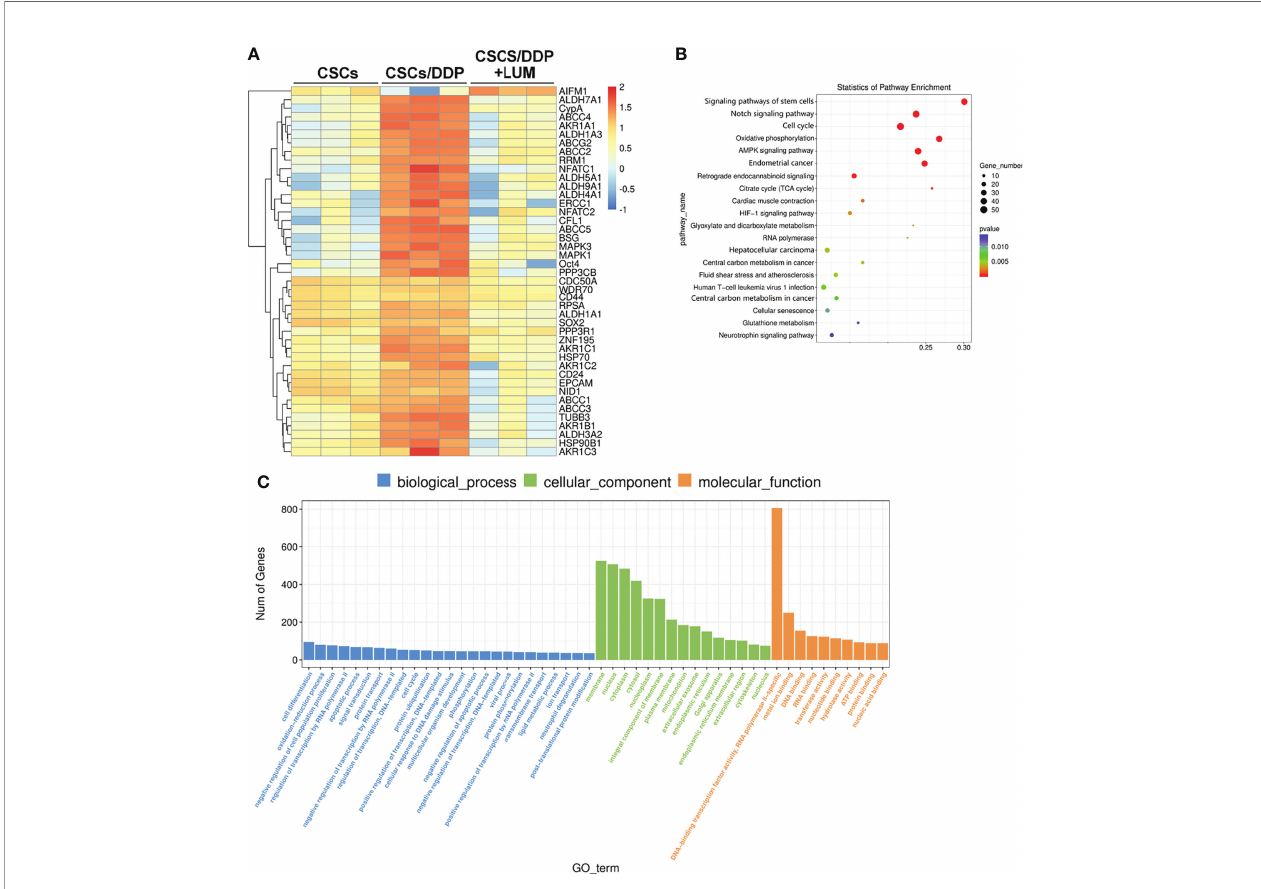
FIGURE 5 | RNA-seq analysis of transcriptome changes in lumi fl avin on DDP-resistant cancer stem cells (CSCs/DDP). CSCs, CSCs/DDP were treated with 80 m M DDP, and CSCs/DDP were treated with 80 m M DDP and 80 m M lumi fl avin for 72 h. The transcriptome changes were detected by RNA-Seq assay. (A) Enrichment analysis of RNA-Seq assay. (B) Scatter diagram of KEGG enrichment analysis results of RNA-Seq assay. (C) Gene ontology analysis was utilized to evaluate the canonical pathways in the RNA-Seq assay results. Mean ± SD (n = 3). CSCs, CSCs were separated from OVCAR-3 cells line; CSCs/DDP, CSCs were separated from OVCAR-3/DDP cells line; LUM, lumi fl